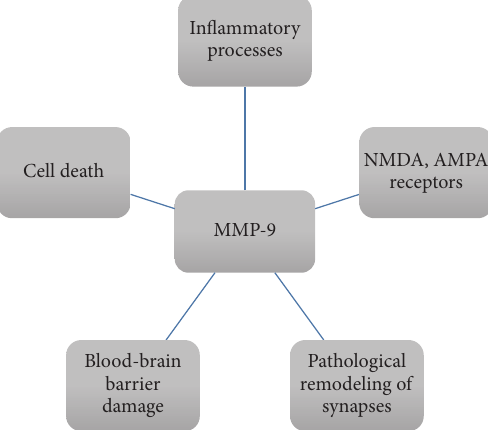
Figure 1: The fields of MMP-9 action in